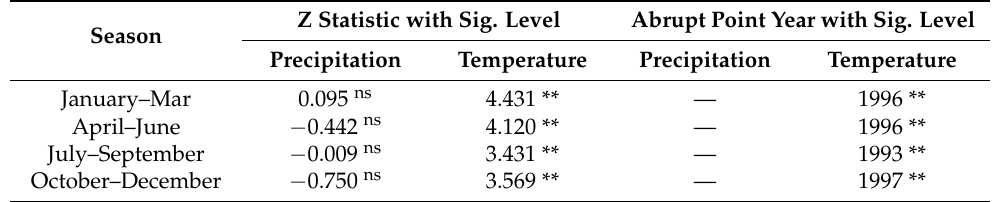
Table 5. Results of trend and abrupt ‐ point analysis for precipitation and temperature in different quarters. Season Z Statistic with Sig. Level Abrupt Point Year with Sig. Level Season